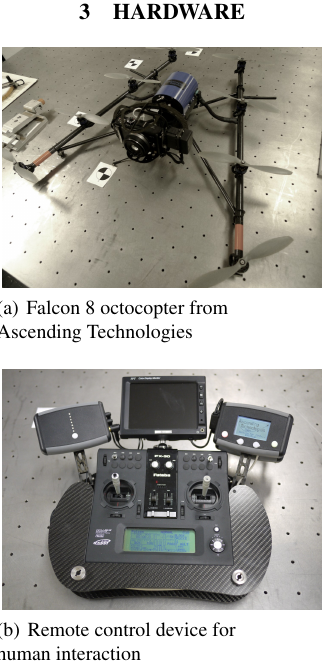
Figure 1: Hardware used for this